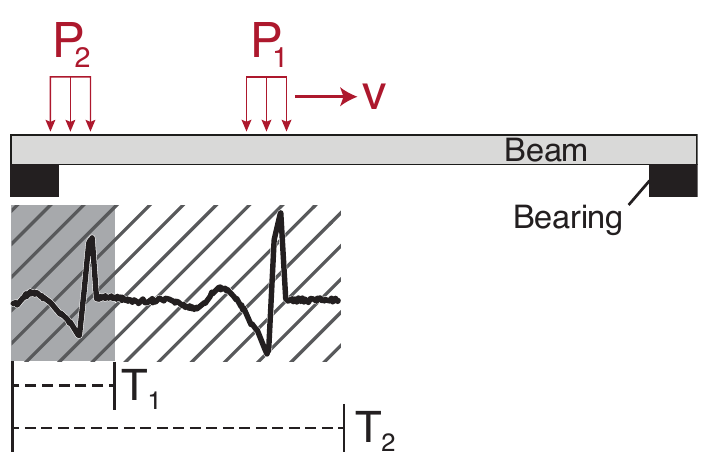
Figure 7. Sketch of impact loading caused by entry of vehicle axles.